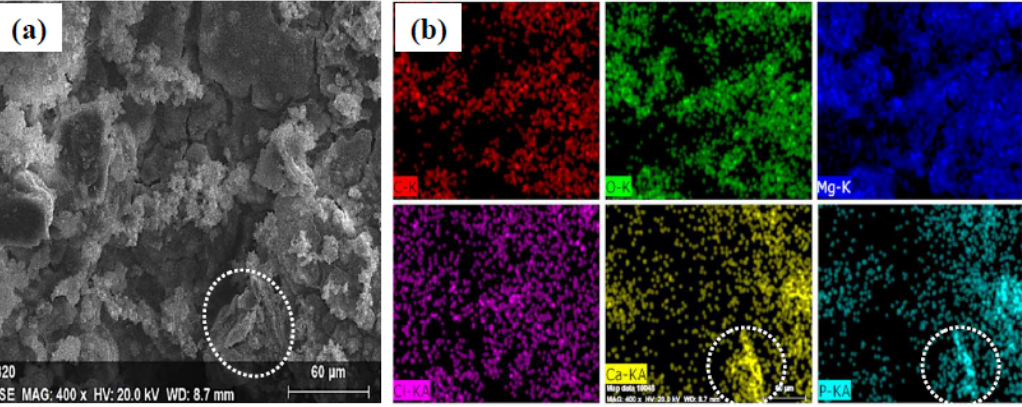
Figure 7. Elements distribution of corrosion products for MZM-1.10% Ca alloys: ( a ) SEM morphologies; and ( b ) main solute elements distribution.